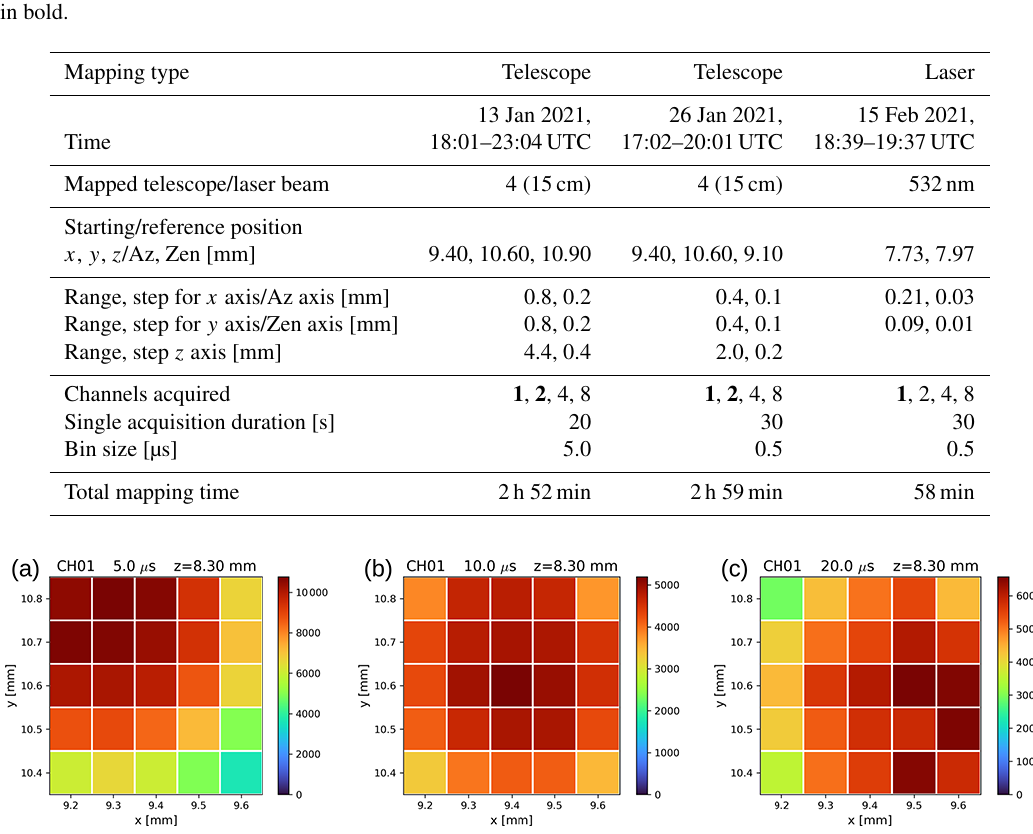
Table 6. Characteristics of the two telescope mapping sessions and the laser mapping session; the channels used for the procedure are highlighted in bold.